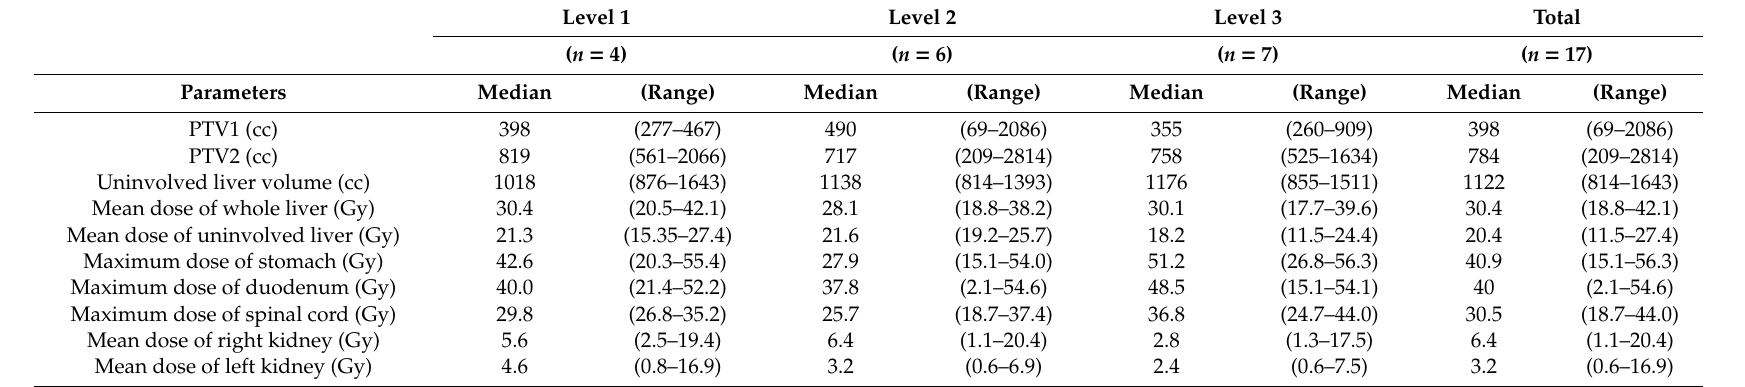
Table 2. Dosimetric parameters based on radiation dose